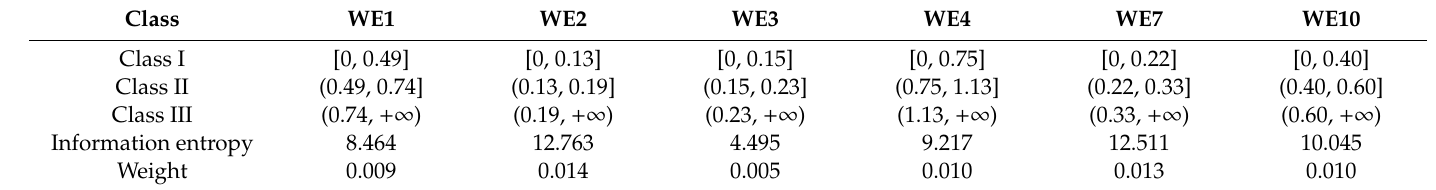
Table 3. The classification results and weights of dam leakage.